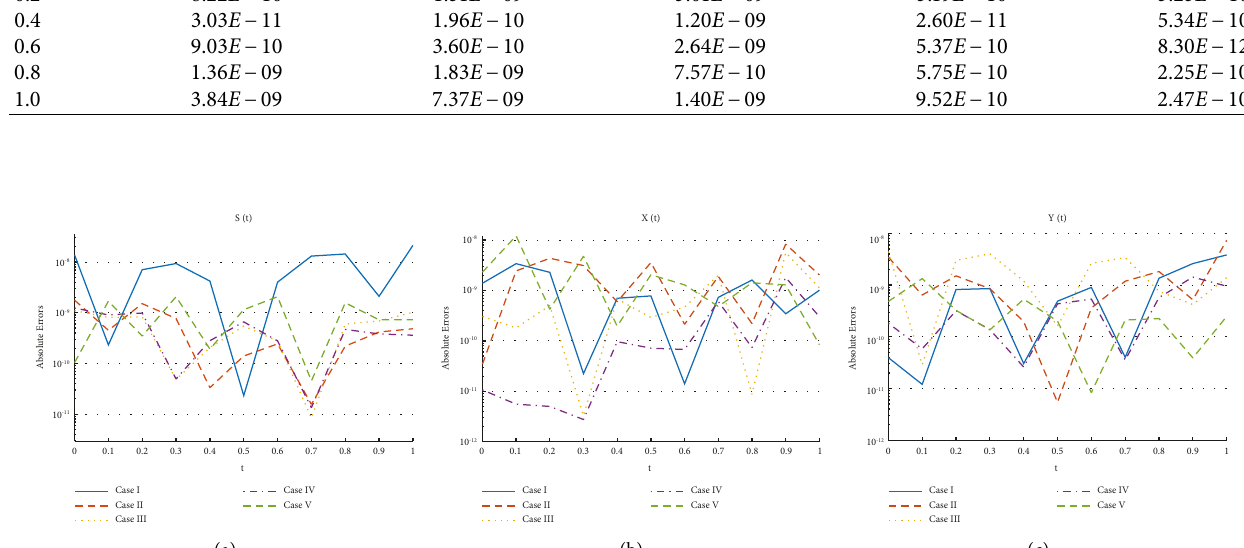
Figure 7: Absolute errors obtained by the LeNN-WOA-NM algorithm under the influence of variations in β prey-predator model. (a) Population density of local prey. (b) Population density of immigrant prey. (c) Population density of the